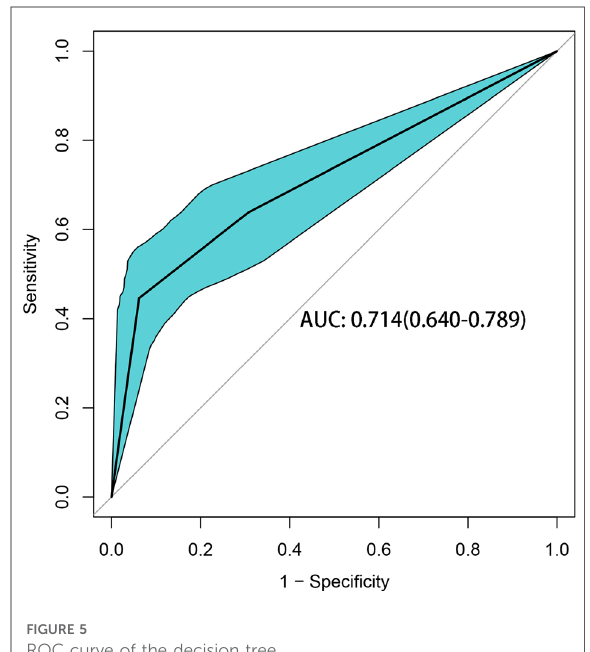
FIGURE 5 ROC curve of the decision tree.